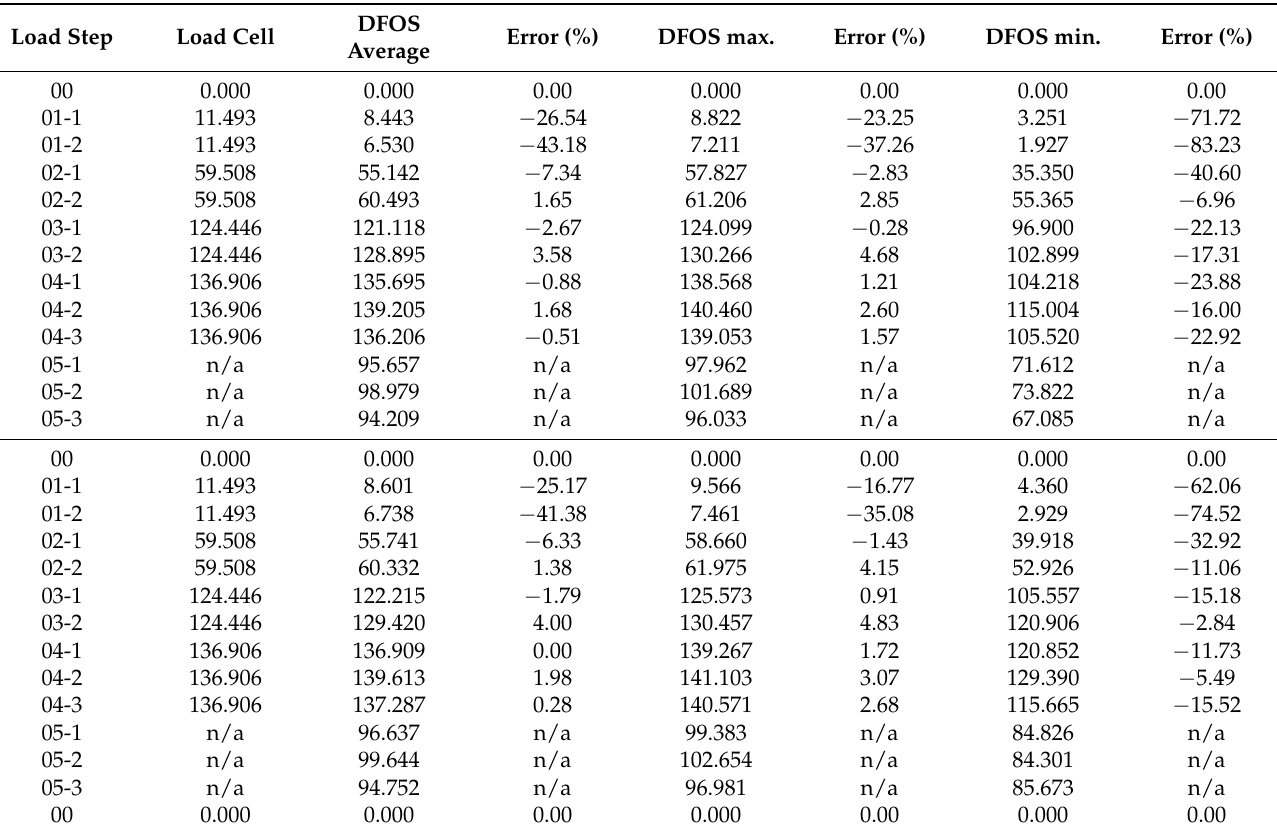
Table 10. Prestressing force monitored by load cell and DFOSs for PC4-1 (unit: